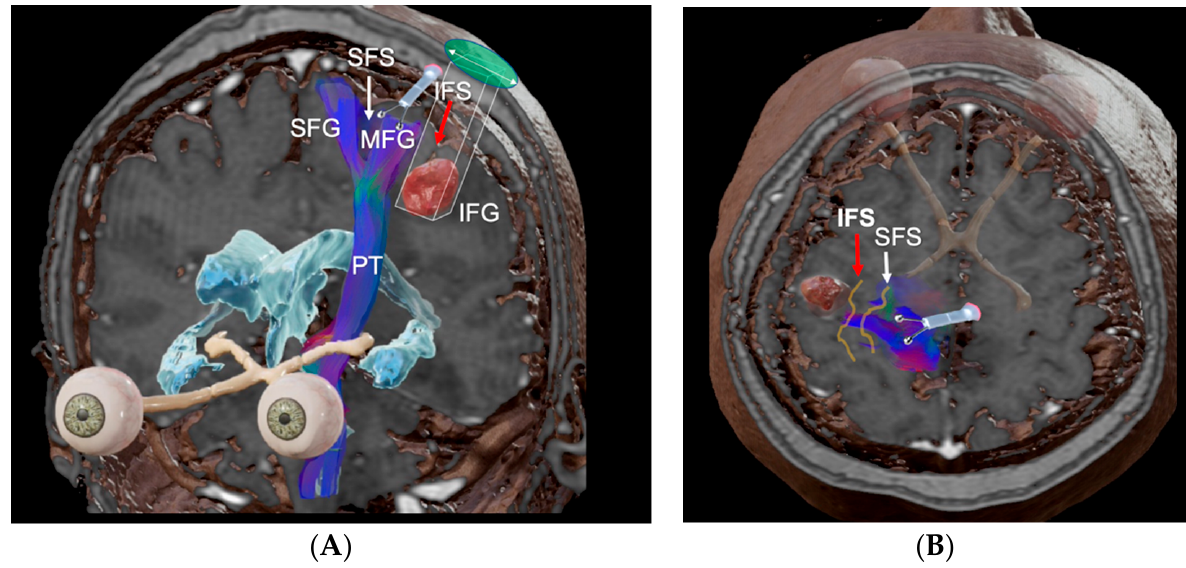
Figure 4. An intra-axial tumor at the junction of the inferior frontal gyrus and the pre-central sulcus. Fig ( A ) shows coronal view of merged T1 weighted MRI scan with corticospinal tract tractography. Fig ( B ) shows the axial view of the la tt er.